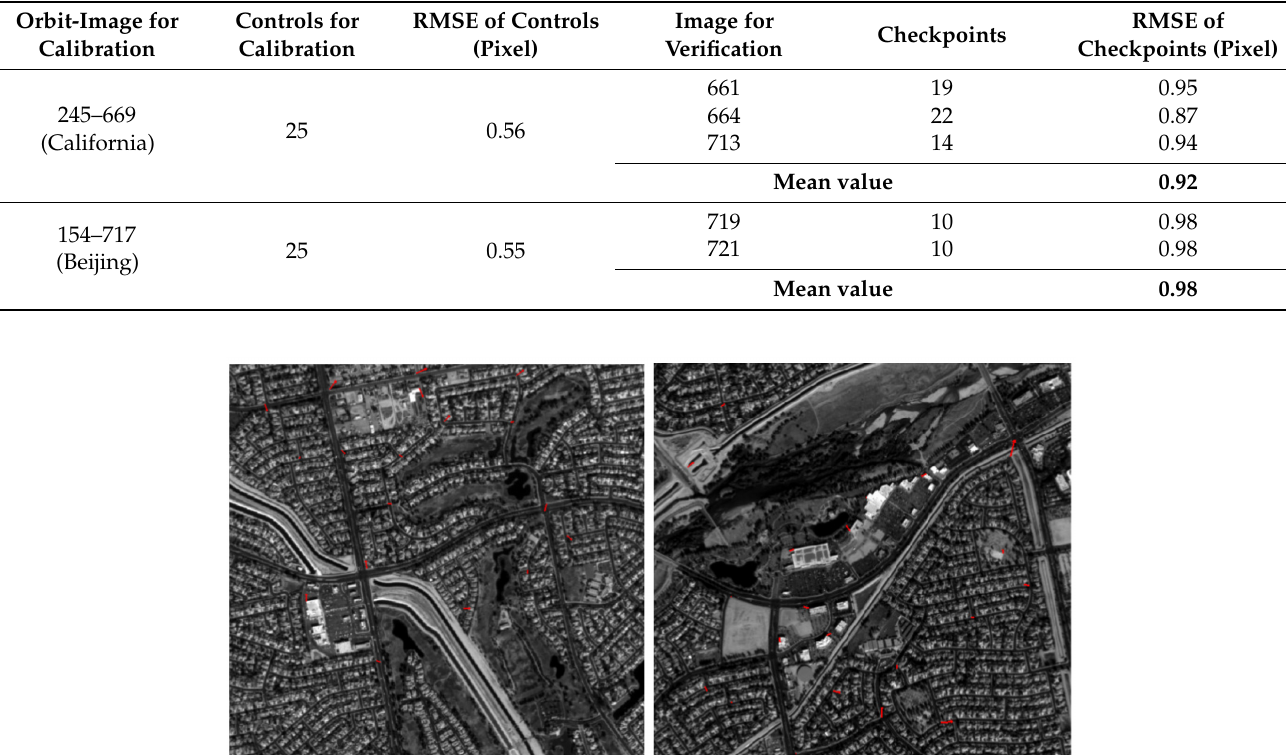
Table 1. Single-image calibration and verification results of the same orbit data.